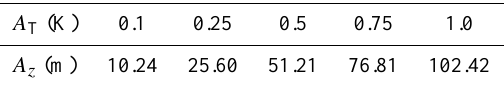
Table A2. Amplitudes of temperature A T , and vertical displace- and N ment A z , c p N · A T for different stability g